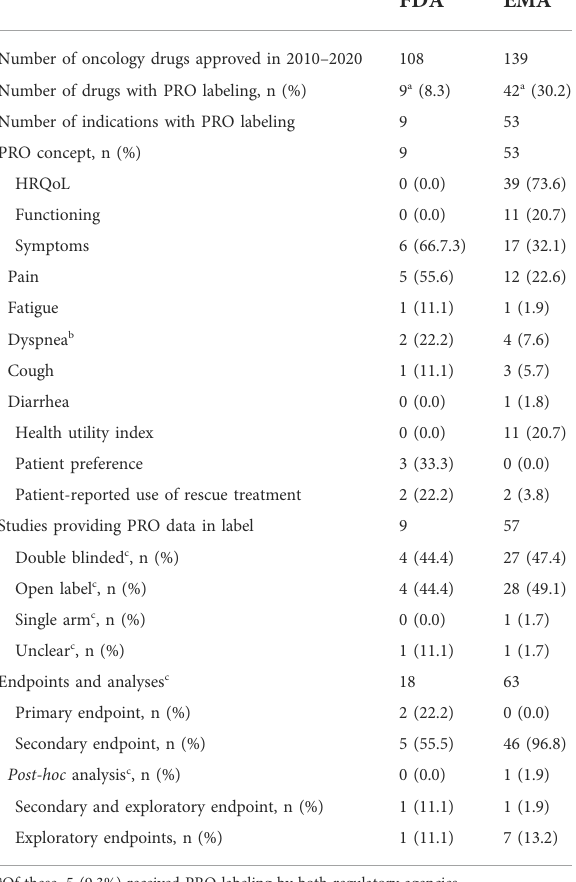
TABLE 1 Overview of EMA and FDA PRO labeling in oncology.